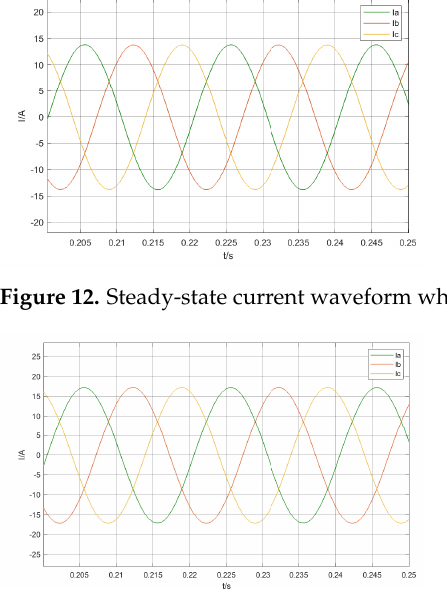
Figure 13. Steady-state current waveform when m = 0.75, D =